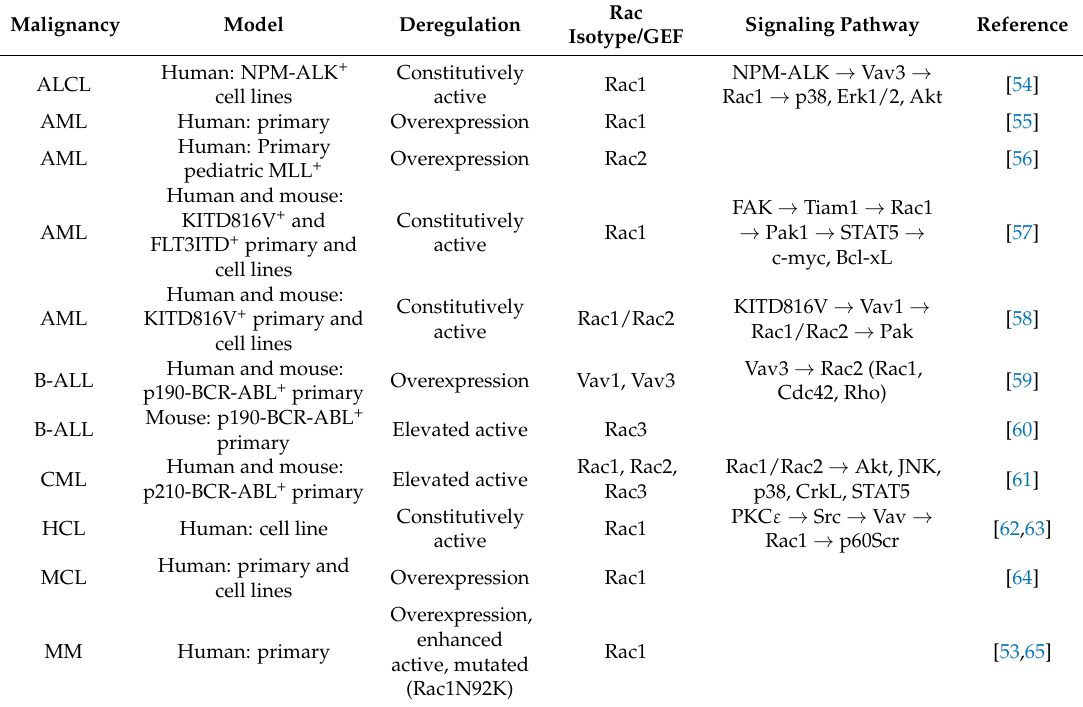
Table 1. Deregulations of Rac